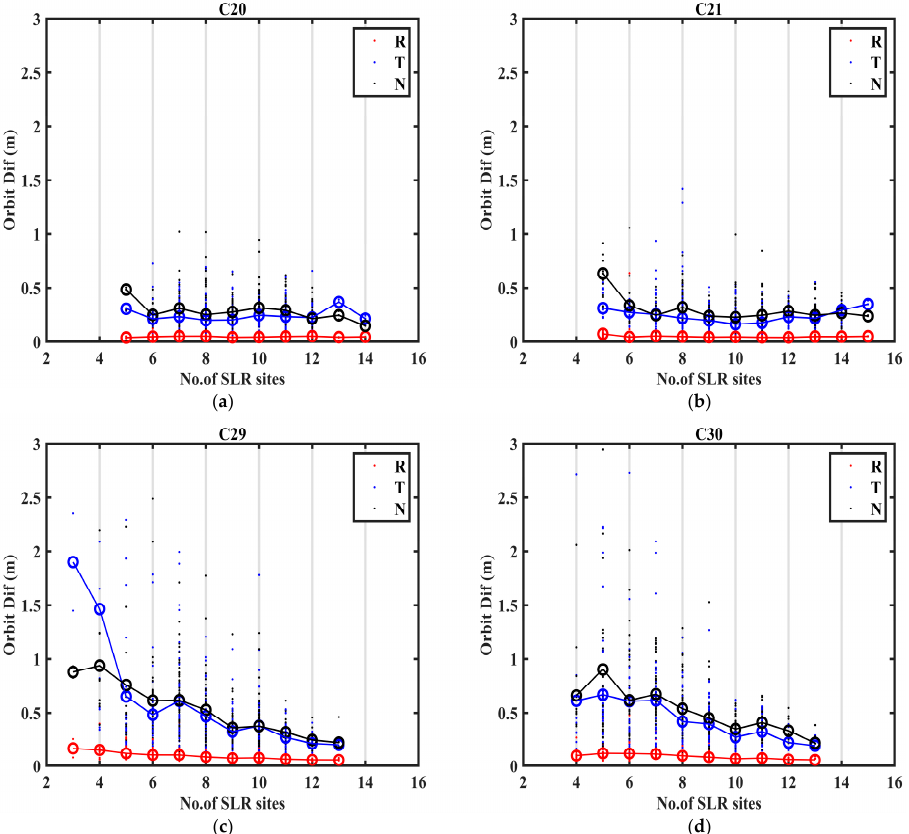
Figure 8. The relationship between the number of stations and the median RMS values. The de fi ni- tions of di ff erent color dots and circles are the same as in Figure 7. Subplot ( a – d ) represents C20, C21, C29, and C30 satellites, respectively.